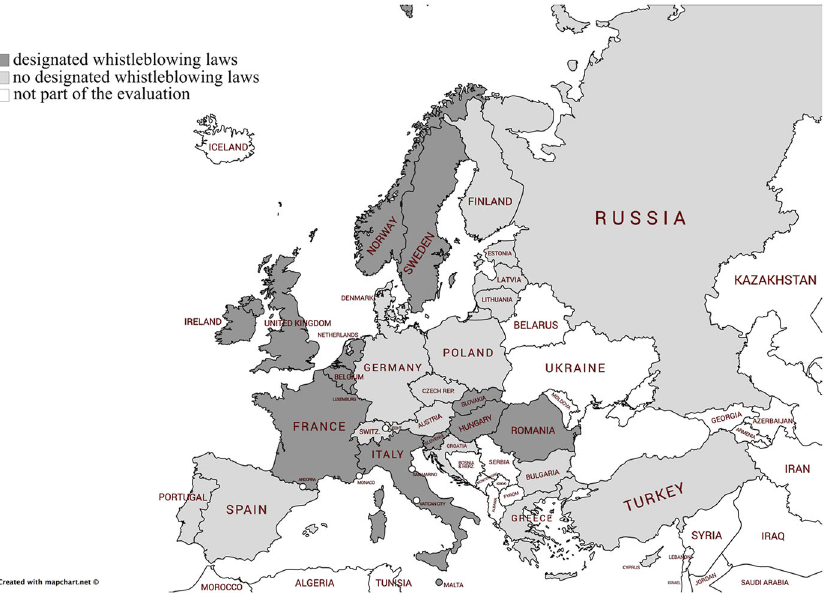
Fig. 2 Overview of whistleblowing laws in Europe and select other